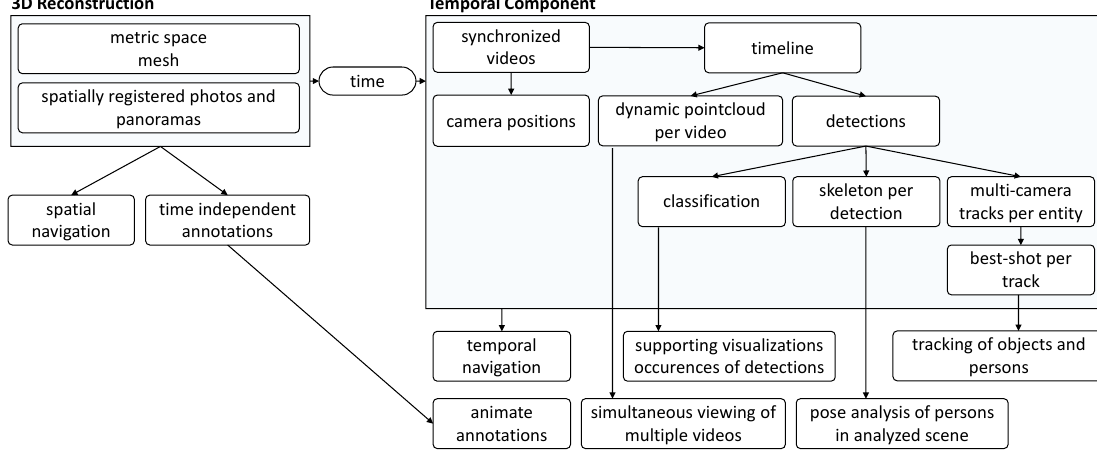
Figure 11. Main elements of the analysis